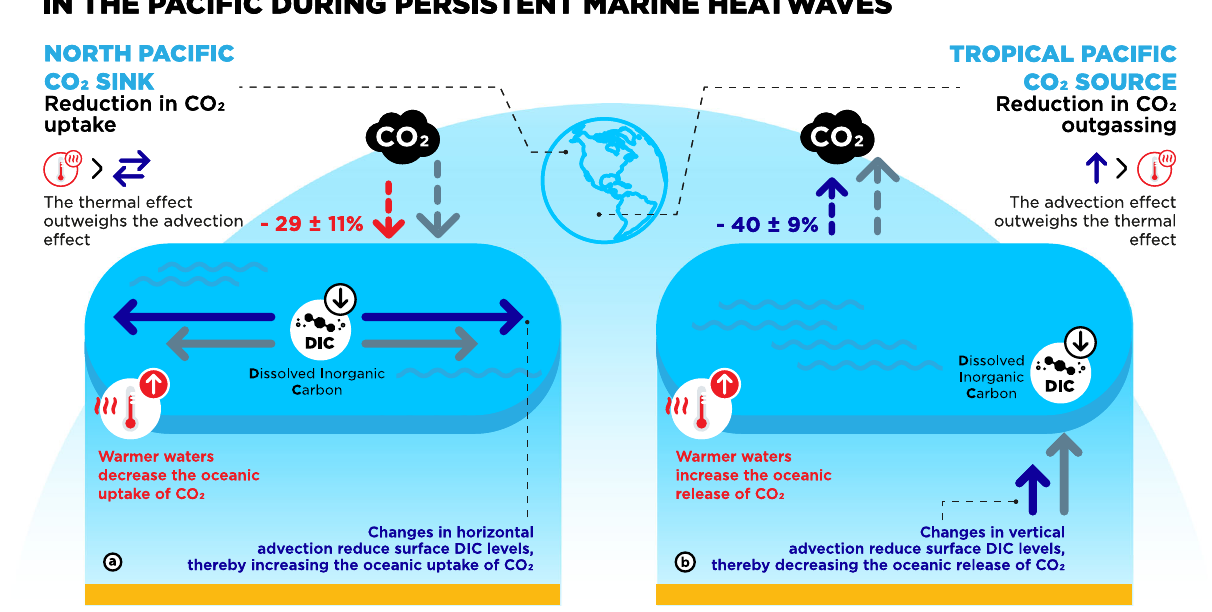
Fig.3|Schematicpresentationofthemechanismsdrivingthereductioninthe air-sea CO 2 fl ux density in (a) the North Paci fi c CO 2 sink and (b) the Tropical Paci fi c CO 2 source regions. Red color indicates the thermal effect on the air-sea